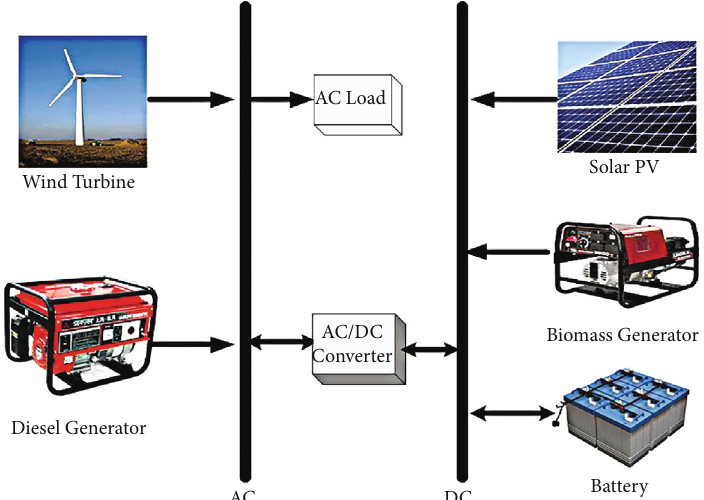
Figure 2: Schematic diagram of hybrid energy